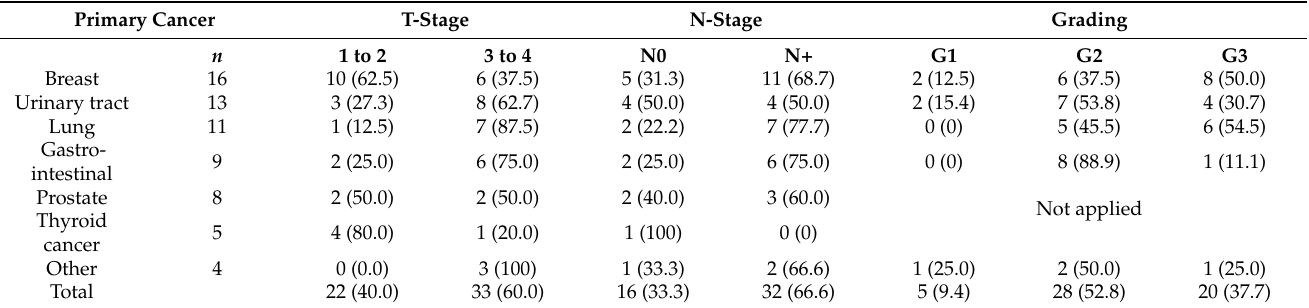
Table 1. Clinical and cancer characteristics of bone metastasis patients with various primary cancers. Two of the four patients in category “other” had oral squamous cell carcinoma, one had a parotid gland carcinoma and one an olfactory neuroblastoma. Abbreviations: T-stage—tumour stage (de- scribes the size/infiltration depth of the primary tumour); N-stage—node stage (describes whether the cancer metastasised to the lymph nodes); Grading, G1—well differentiated—to G3—poorly differentiated (describes the cancer cell differentiation compared to normal cells).